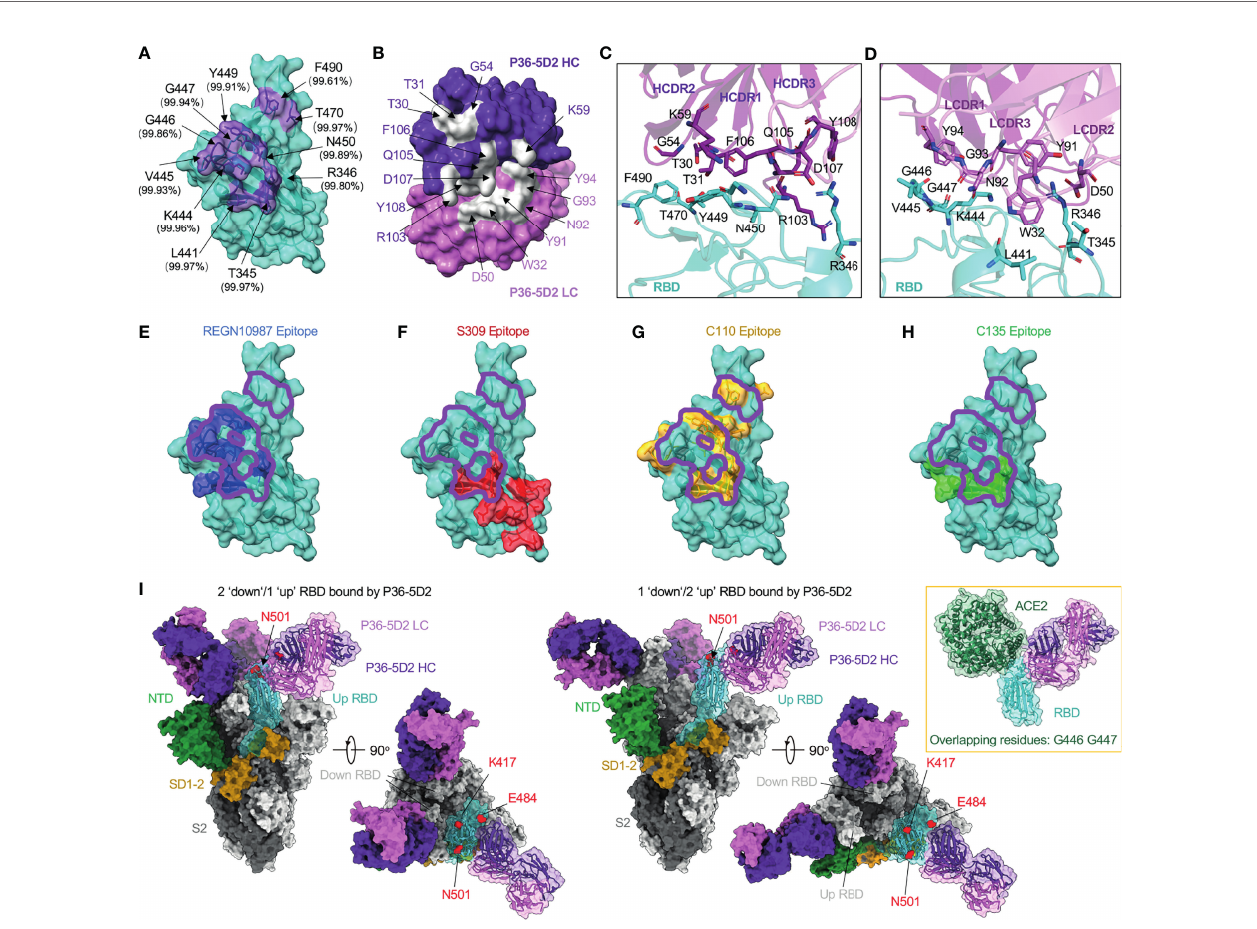
FIGURE 2 | P36-5D2 binds to a highly conserved epitope on the receptor-binding domain (RBD) and avoids three key mutant residues: K417N, E484K, and N501Y. (A) The epitope of P36-5D2 ( purple ) is highlighted on the surface of severe acute respiratory syndrome coronavirus 2 (SARS-CoV-2) RBD-3M carrying K417T, E484K, and N501Y ( cyan ) (PDB: 7FJC). RBD-3M residues on the epitope are labeled. The percentages show the conservation at these positions observed in the GISAID EpiCoV database by aligning 1,959,333 sequences of the SARS-CoV-2 spike from December 2019 to July 2021. (B) The paratope of P36-5D2 ( sliver ) is highlighted on heavy chain ( purple ) and light chain ( pink ). Antibody residues are labeled in purple or pink depending on their origin from heavy or light chain. (C, D) Interaction between P36-5D2 Fab and SARS-CoV-2 RBD-3M. (E – H) Listed class III mAbs Fab fragments are superposed onto P36-5D2/RBD-3M crystal structure. REGN10987, S309, C110, and C135 are reference class III mAbs. The epitopes of these antibodies were assigned by selection of any RBD residue within 4 Å of any antibody residue. The epitope of REGN10987 (PDB: 6XDG) is colored in blue , S309 (PDB: 7JX3) in red , C110 (PDB: 7K8V) yellow , C135 (PDB: 7K8Z) green , and P36-5D2 in purple . (I) Electron cryo-microscopy (cryo-EM) for the P36-5D2 Fab and SARS-CoV-2 spike complex ( left , 3.65 Å; right , 3.69 Å) reveals the binding of P36-5D2 Fab to both “ up ” and “ down ” RBDs. P36-5D2/RBD-3M crystal structure shown as cartoon superposed onto one protomer of P36-5D2/spike cryo-EM structure. The spike is shown as a molecular surface, with one protomer RBD colored cyan , NTD green , SD1-2 yellow , and S2 gray . The top view shows that P36-5D2 avoids residues K417, E484, and N501, which are shown as red-colored spheres . Inset : structure superposition showing clashes between ACE2 (PDB: 6MOJ; green ) and P36-5D2 Fab. Overlapping residues shared between P36-5D2 and ACE2 are listed